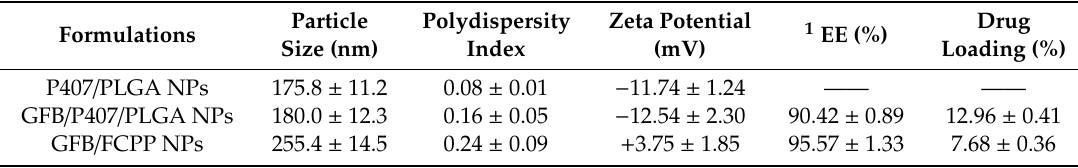
Figure 2. Scanning electron microscopy (SEM) photomicrographs of ( A ) GFB / P407 / PLGA NPs, ( B ) GFB / FCPP NPs, ( C ) GFB / FCPP-NEMs (inset, high magnification image, scale bar = 1 µ m), and ( D ) GFB / FCPP-NEMs after exposure to PBS (pH 7.4). The arrow is pointing to the GFB / FCPP NPs, while the square frame contains a GFB / FCPP-NEM. Table 1. Characterization of different samples ( n = 3).